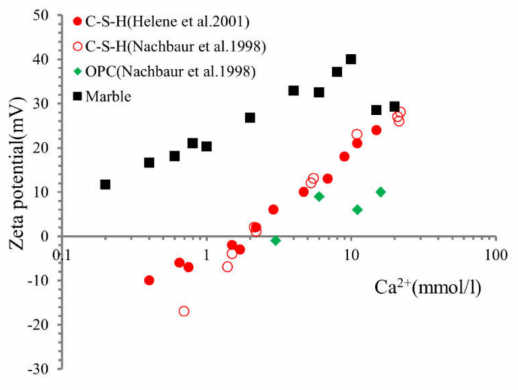
Figure 3. Development of the zeta potential of the marble, C–S–H, and OPC particles with increasing Ca 2 + concentration.